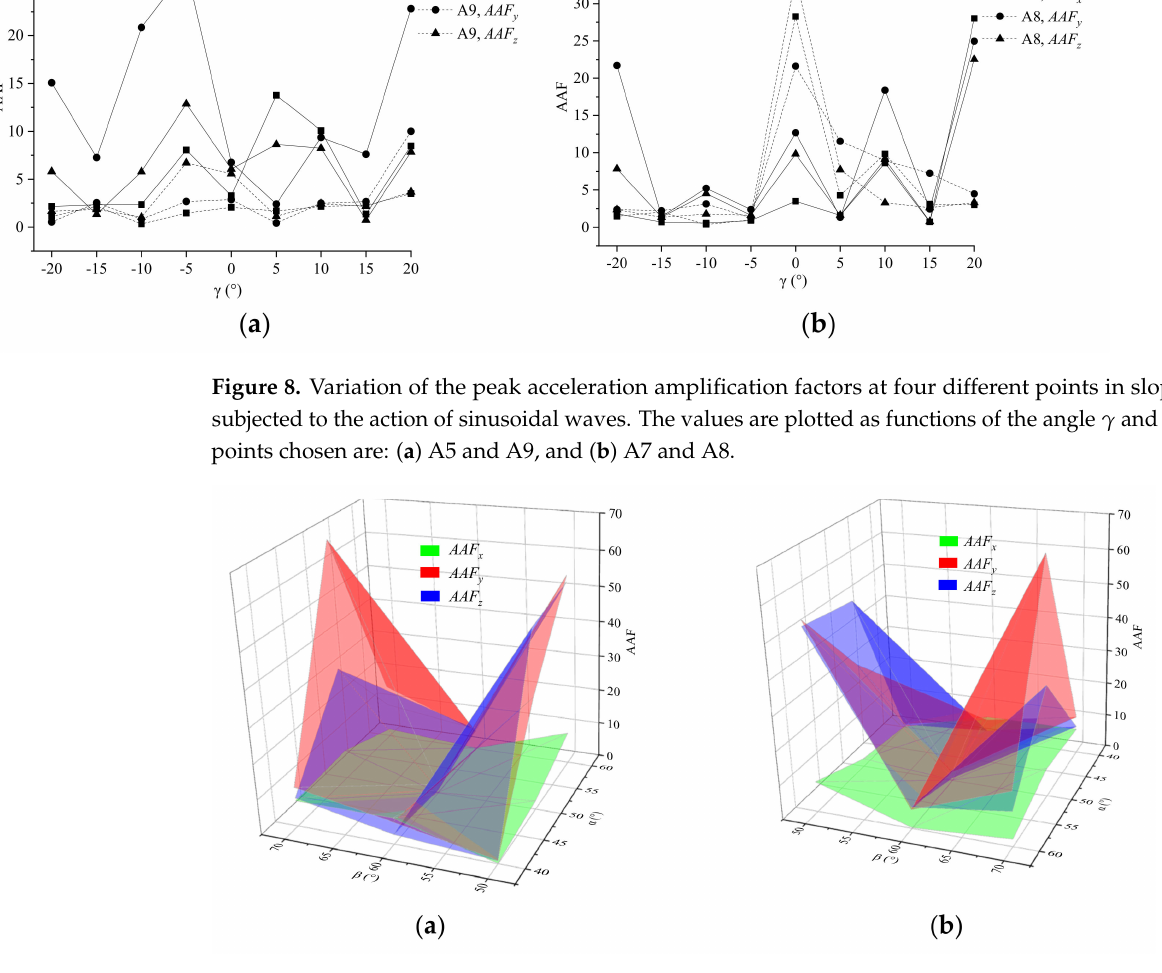
Figure 9. Variation of the three-directional peak AAF values at point A8 with slope angle α and joint angle β : ( a ) under the action of sinusoidal waves, and ( b ) under the action of natural seismic